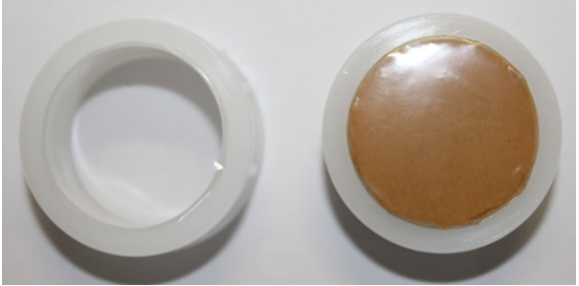
Figure 2. On the left : an empty cup and on the right : a filled cup with a powder. Each sample was analyzed with the three pXRF, three times or more during 10 s, and results were then averaged.